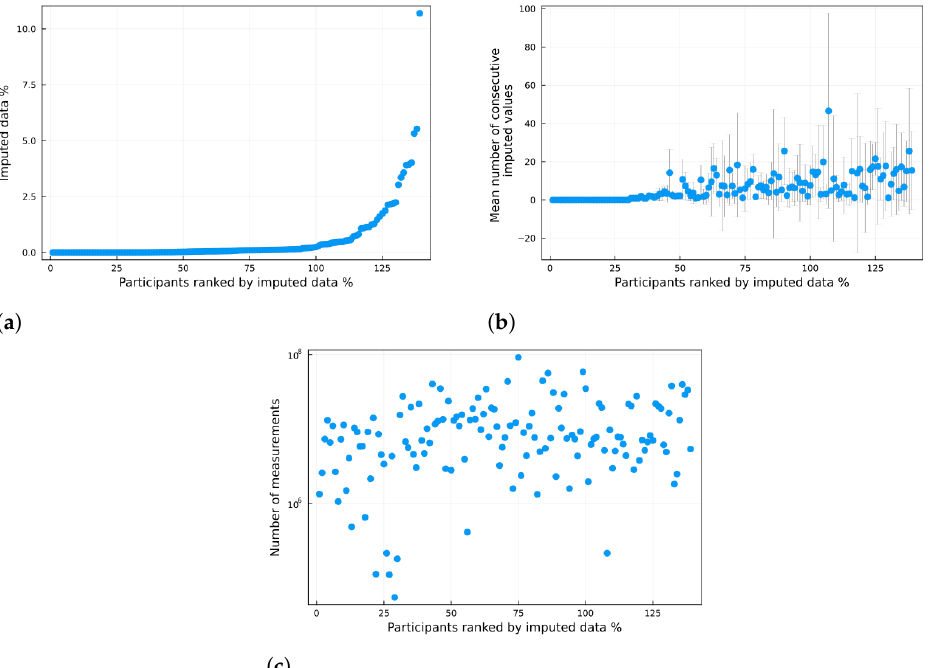
Figure A1. ( a ) Imputed data percentage per individual. ( b ) Mean number of consecutive imputed values per individual. The error bars correspond to the standard deviation. ( c ) Number of measure- ments per individual. In all plots, the x -axis is the ranked imputed data percentage from smallest to